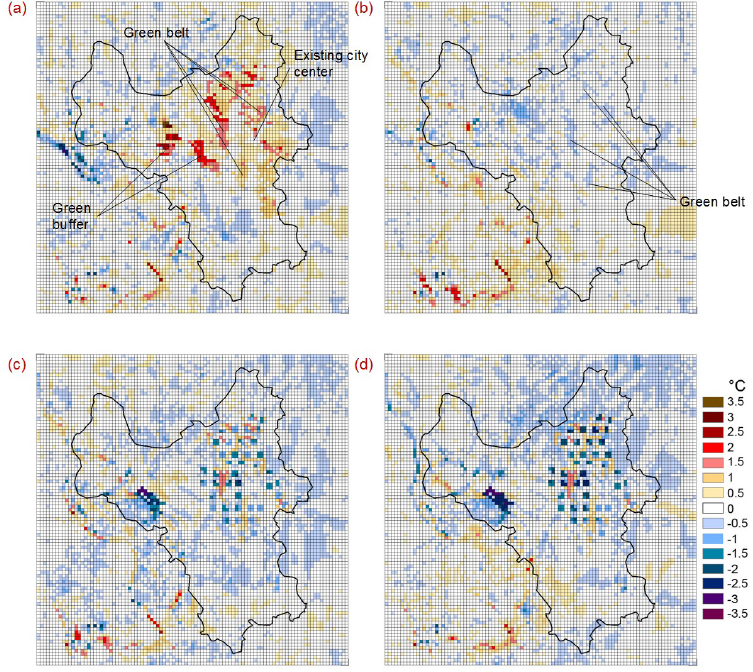
Figure 7. Air temperature difference at 1:00 on 17 June between ( a ) U_HMP-U_NOGREEN; ( b ) U_HMP-U_HMPFOREST; ( c ) U_HMP- U_PARK and ( d ) U_HMP-U_PARKFOREST